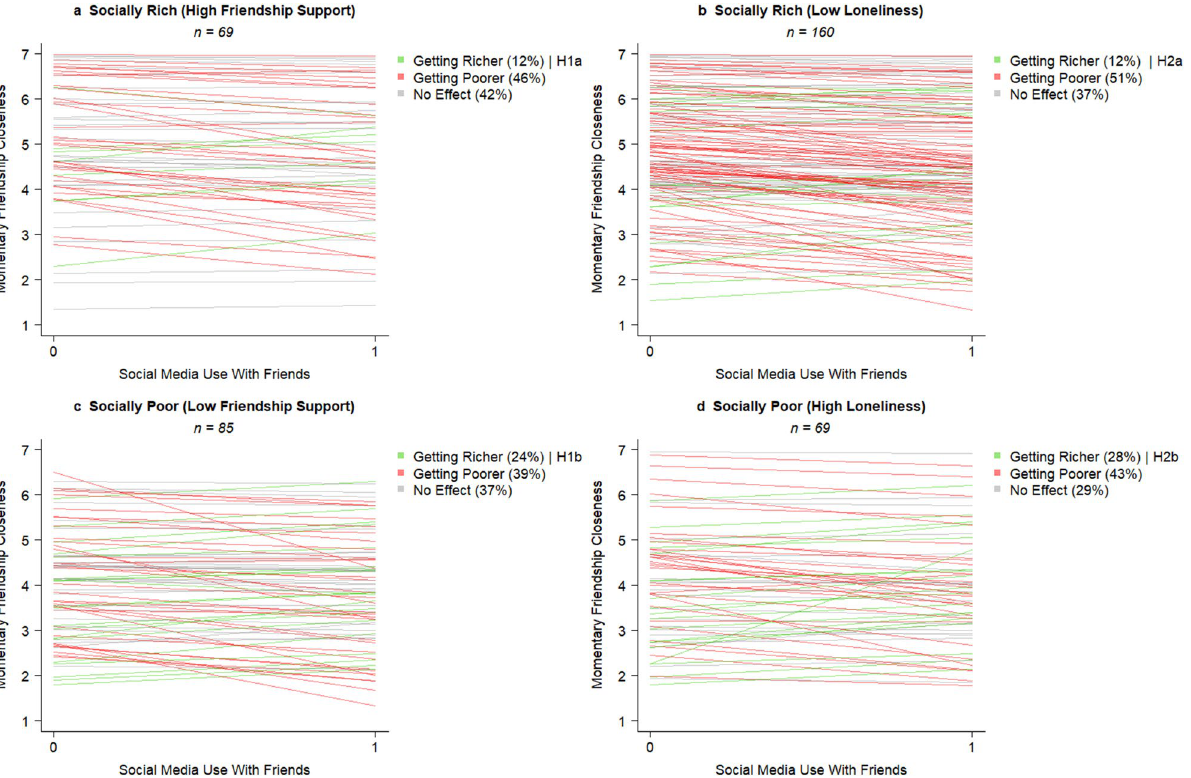
Figure 4. N = 1 Short-term effects of social media use with friends on momentary friendship closeness among socially rich (Fig. 4a & 4b) and poor adolescents (Fig. 4c & 4d). Note. Subgroups of socially rich and poor adolescents were created based on the Mean + /1 SD, with the exception of low loneliness for which we used the absolute minimum of 1. Social media use with friends was dummy-coded (0 = no social media use with friends; 1 = social media use with friends).